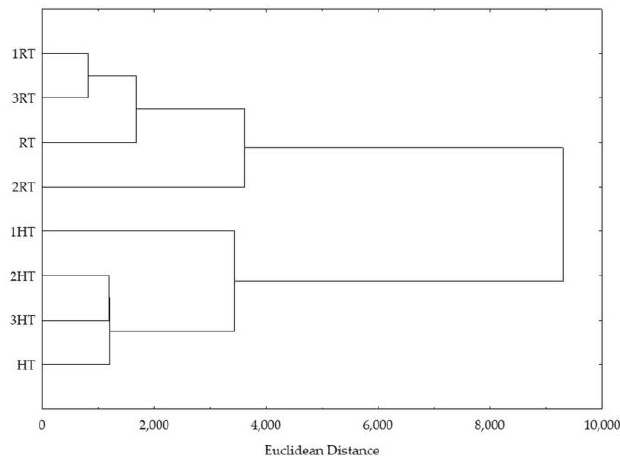
Figure 4. Hierarchical clustering, expressed as Euclidean distance, of control and treated groups of plants, based on the measured total and individual bioactive compounds, their pigments, oxidative stress parameters, antioxidant potential, and ability to inhibit enzymes α -amylase, α -glucosidase, and lipase. HT = plants watered with high temperature water, CT = plants watered with cold water, and Con = plants watered with room temperature water.